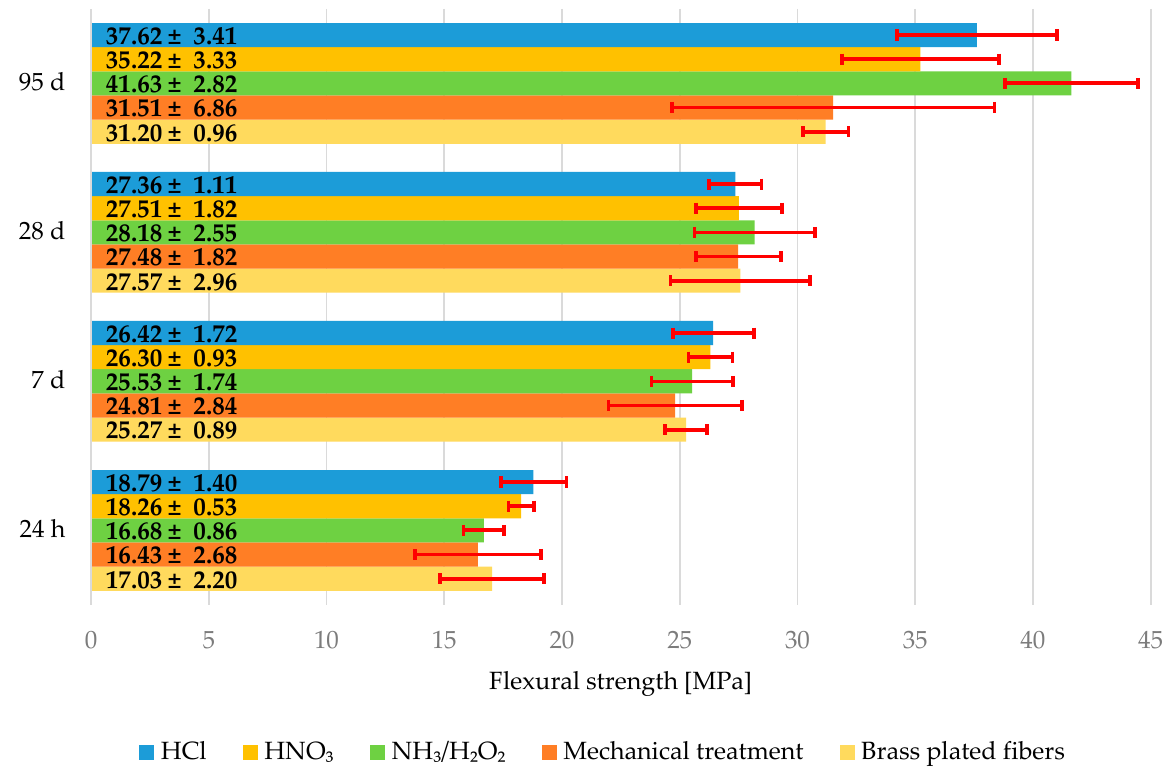
Figure 7. Average flexural strength of the specimens after 24 h, 7, 28, and 95 days. The average values of compressive strength can be seen in graph in Figure 8. The error bars represent the standard deviation. There is a slight reduction in the compressive strength of composites with HNO 3 treated fibers and composites with mechanically treated fibers at every age. The values of compressive strength for composites with brass plated fibers, composites with fibers treated in HCl, and composites with fibers treated in NH 3 /H 2 O 2 are almost the same at every age. However, this indicates that the grooves in the fibers do not contribute very much to compressive strength, although the addition of fibers alone can significantly increase the compressive strength of UHPC [6].